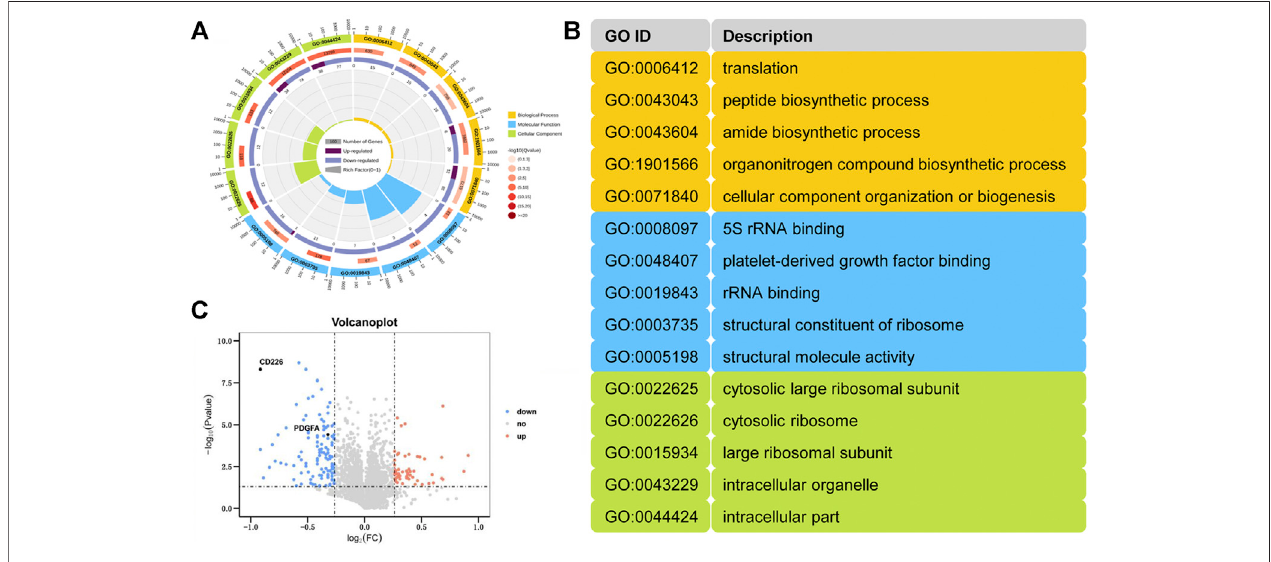
FIGURE 3 | Platelet-speci fi c CD226 absence led to abnormal ribosomal function and structure. (A) A GO analysis of the DEPs. (B) Annotation of the gene ID. (C) Volcano plot of differentially expressing proteins from the CD226 fl / fl PF4-Cre platelet versus littermates ( n (cid:1) 3 per group).